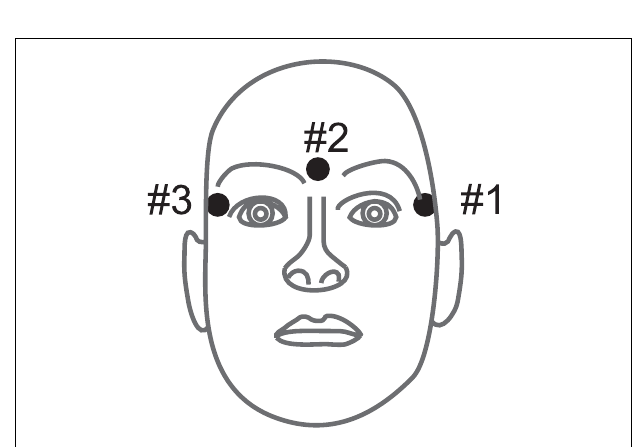
FIGURE 19 | (Data Set 2b). Electrode montage of the three monopolar EOG